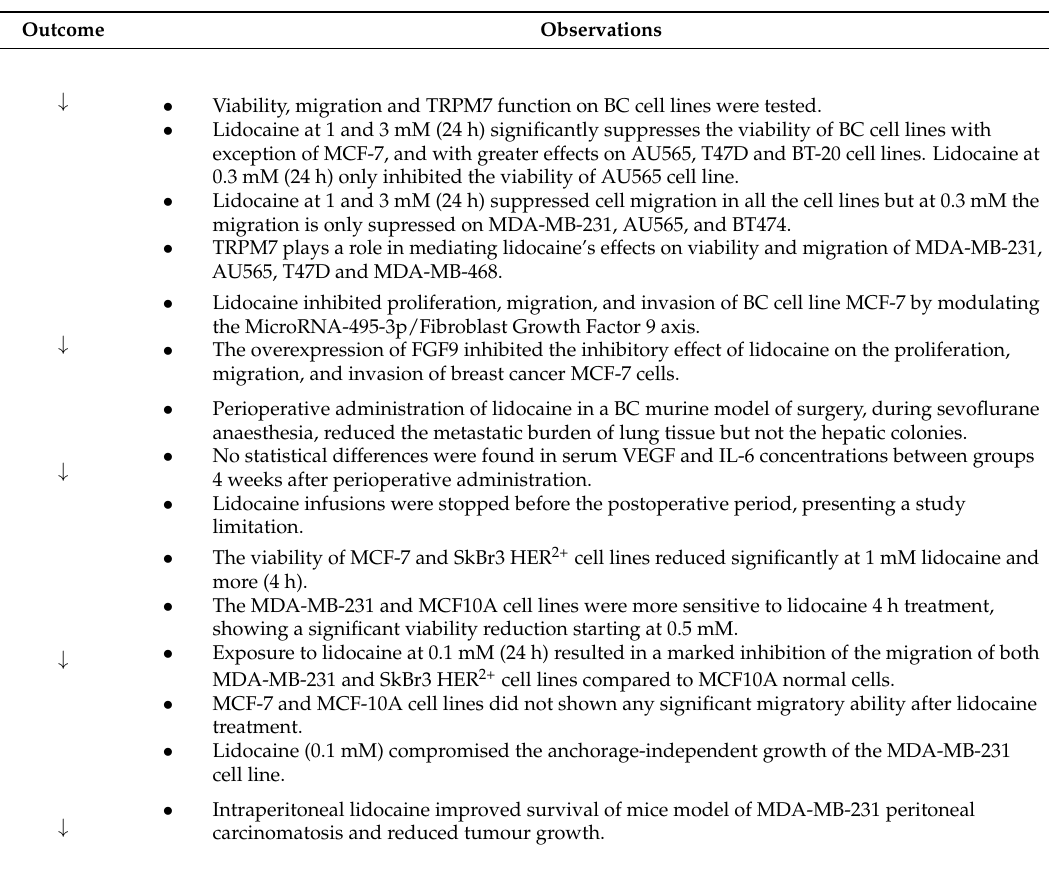
Table 2. The effect of lidocaine, morphine, ropivacaine and levobupivacaine on BC cell lines and its influence in other treatment